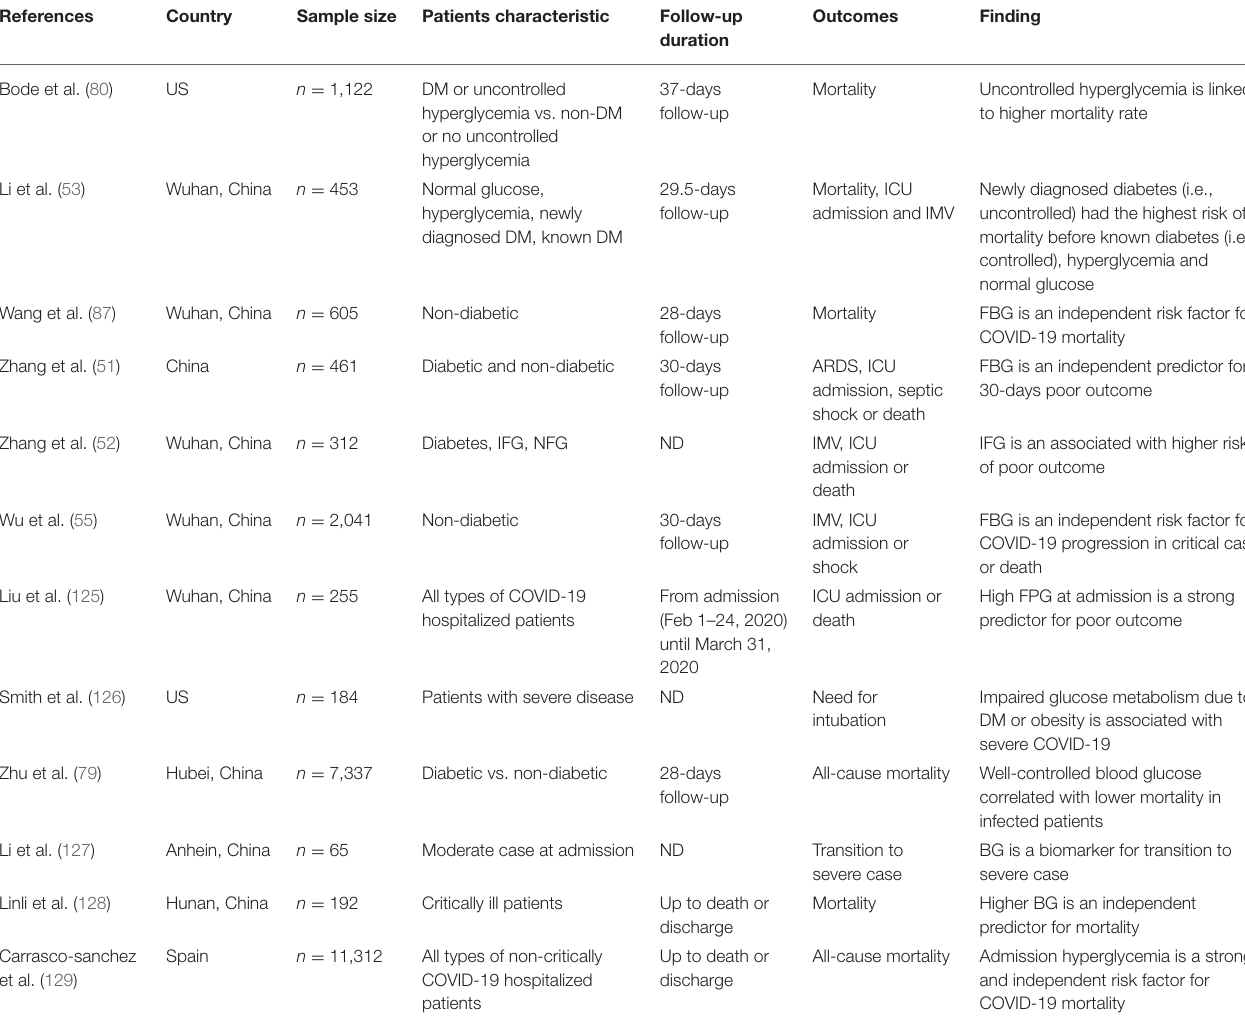
TABLE 2 | Overview of the recent studies showing the association between increased FPG and a poor prognosis and/or increased risk of death from